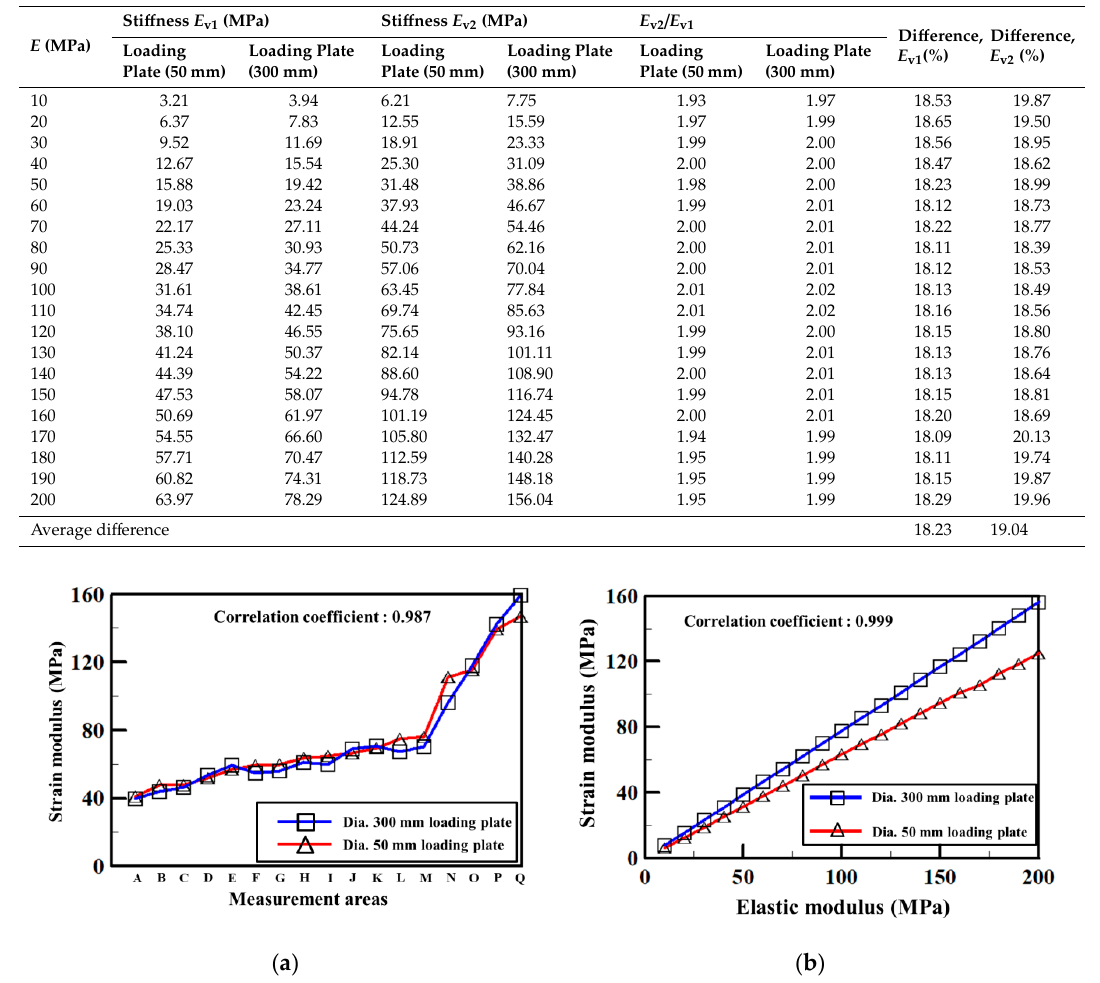
Figure 3. Correlation analysis comparison between the field-test and numerical-analysis results: ( a ) field-test results (Jung et al. [6]); ( b ) numerical-analysis results.